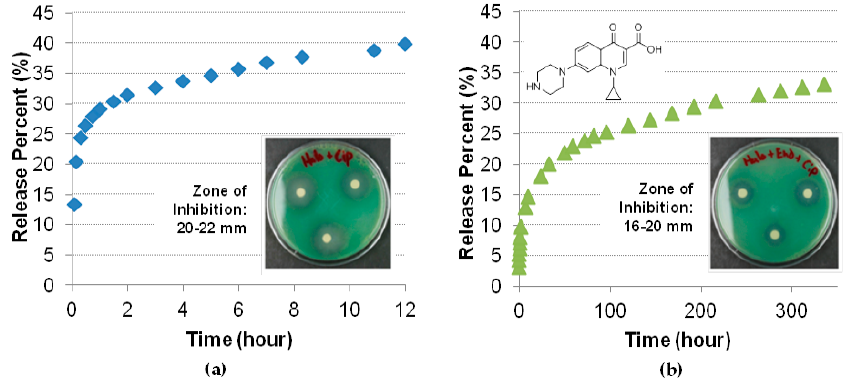
Figure 6. Ciprofloxacin sustained release ( a ) from halloysite tubes and P. aeruginosa inhibition; ( b ) from 8% halloysite composite with polymethmetacrylate bone cement and P. aeruginosa 48 h inhibition. Reproduced with permission from [21], Copyright John Wiley and Sons, 2016.